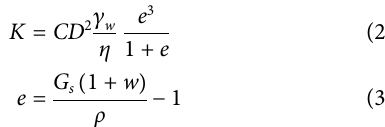
Frontiers in Earth Science |